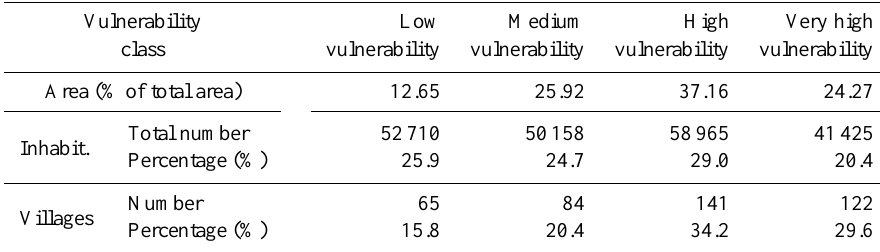
Table 4. Synthetic data of vulnerability factor 3 in Tutova Hills. Vulnerability Low Medium